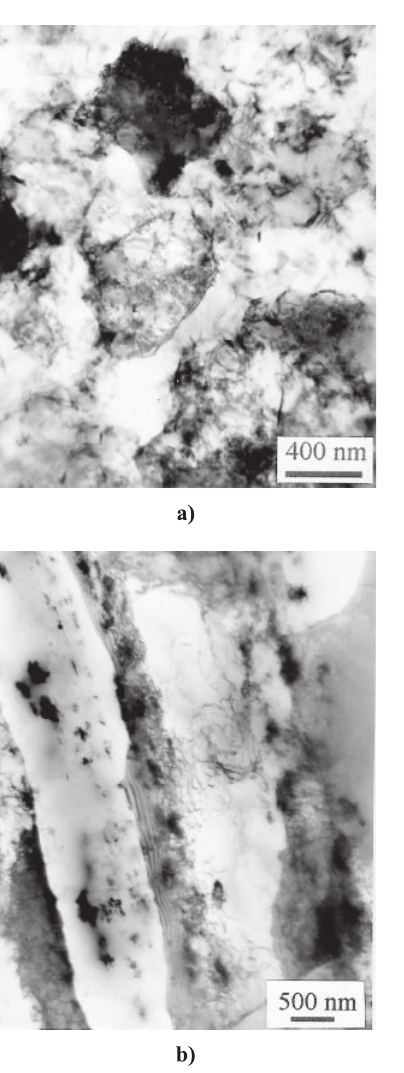
Fig. 14: TEM micrograph of the substructure of Al-4Al 4 C 3 in the transverse direction (a), and in the longitudinal direction (b)